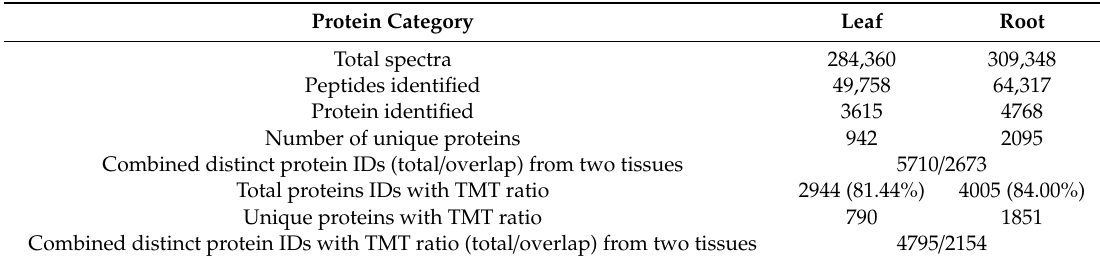
Table 2. Primary results for identified proteins from mulberry leaves and